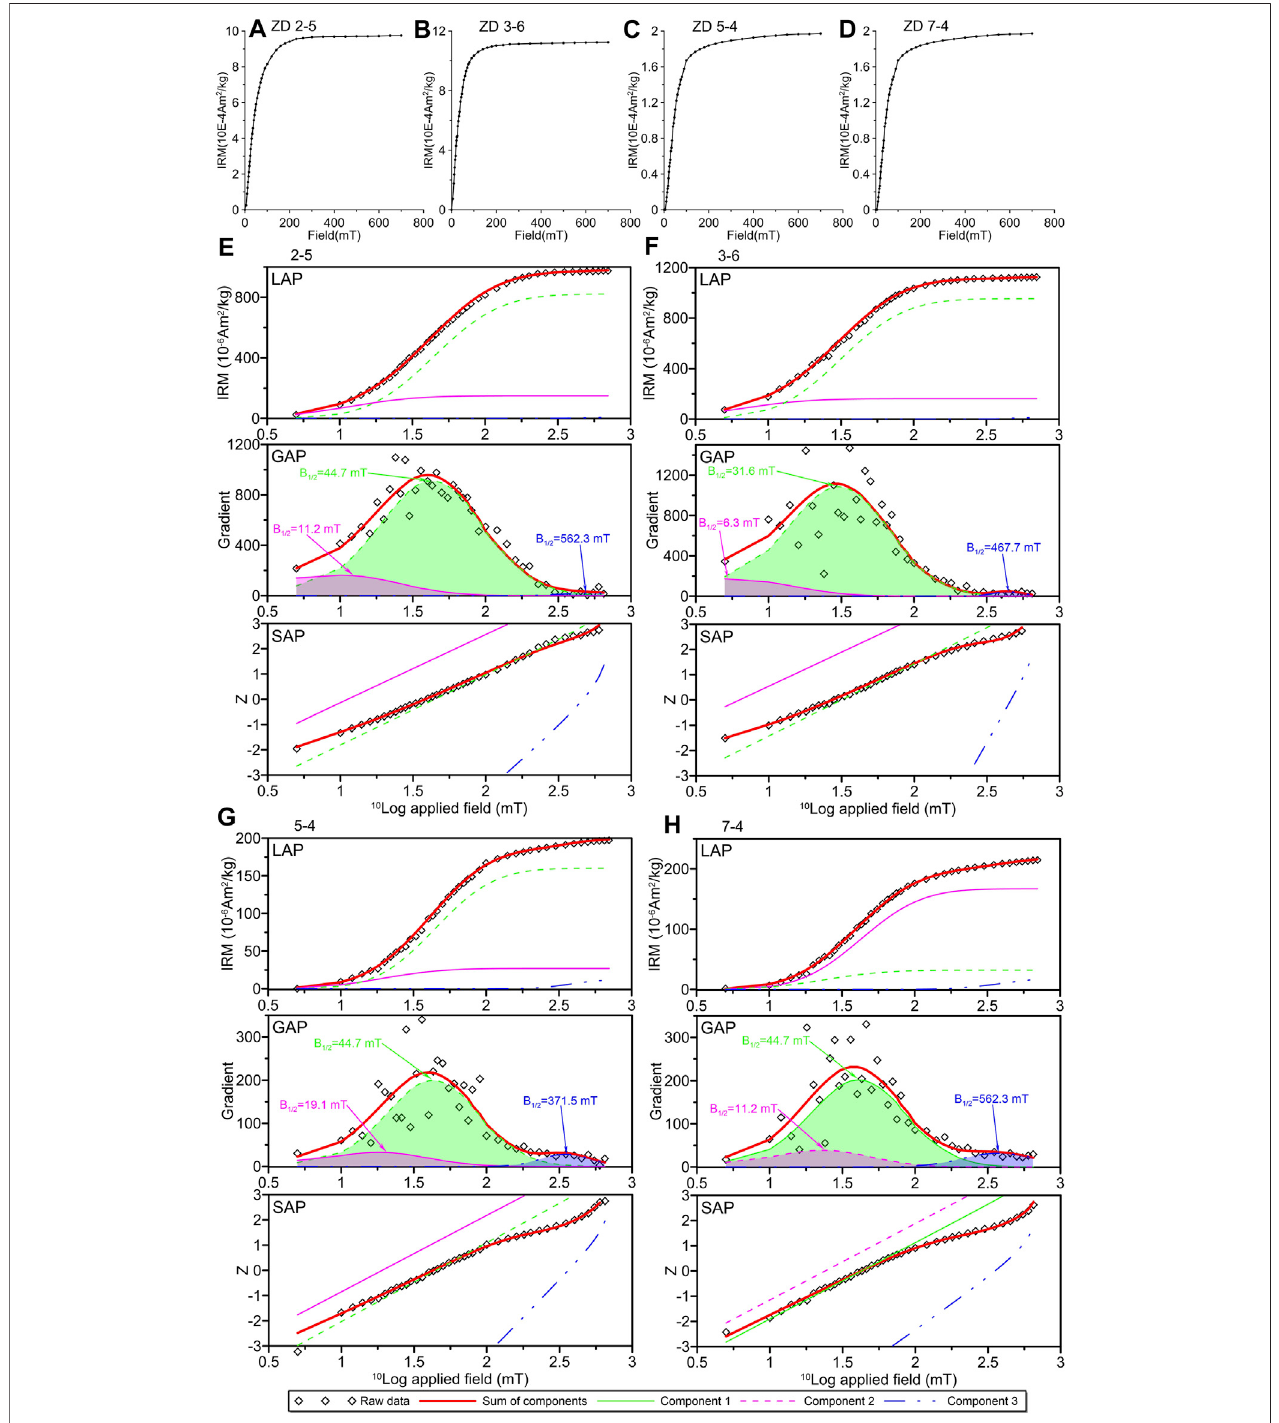
FIGURE5|(A – D) IRMacquisitioncurvesofrepresentativesamples. (E – H) IRMcomponentanalysisplots(Kruiveretal.,2001)ofrepresentativesamples.Squares are measured data points. The components are marked with different colored lines. B 1/2 and DP are in log 10 mT. LAP: linear acquisition plot, GAP: gradient acquisition plot and SAP: standardised acquisition plot.